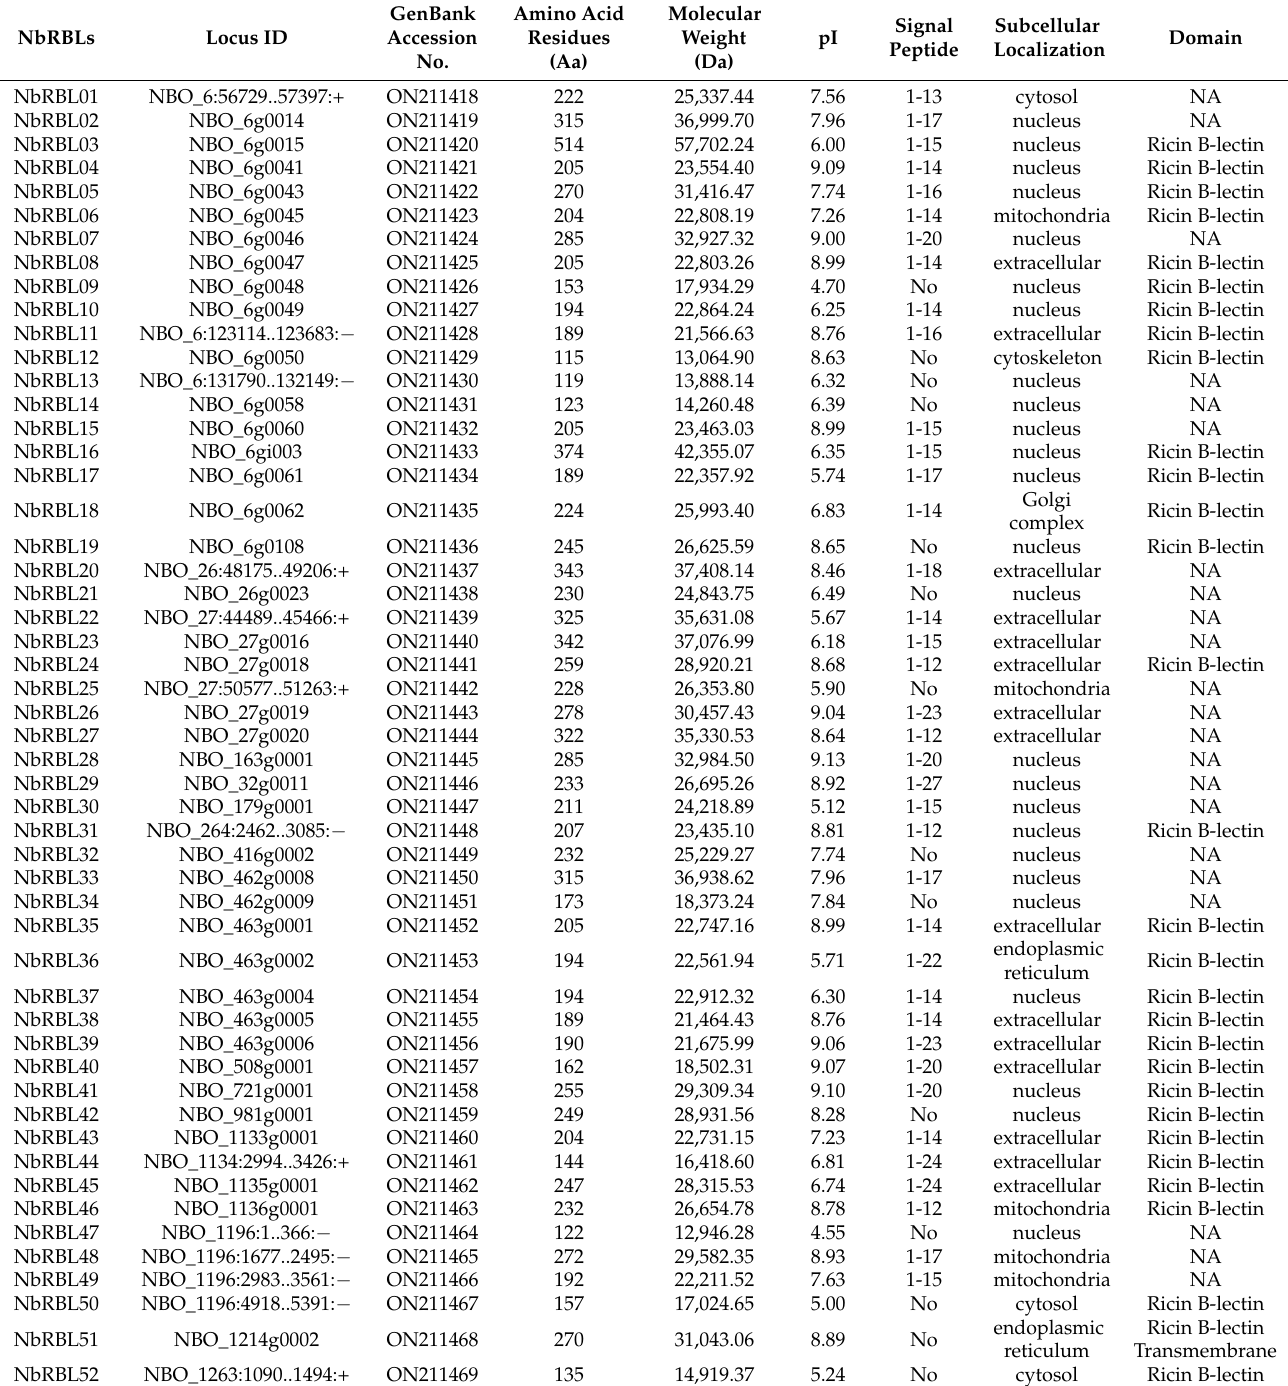
Table 2. The NbRBLs identified in N. bombycis